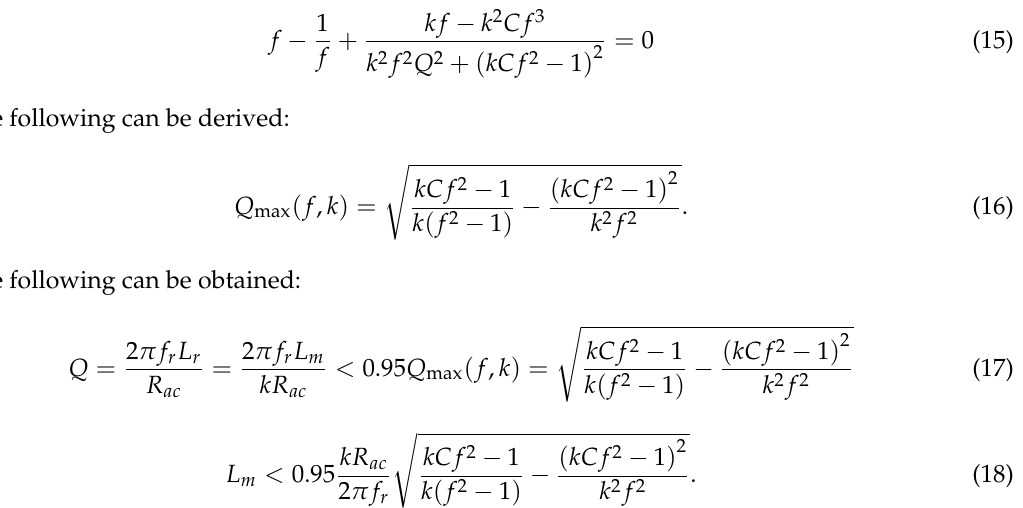
represents the resonant frequency;